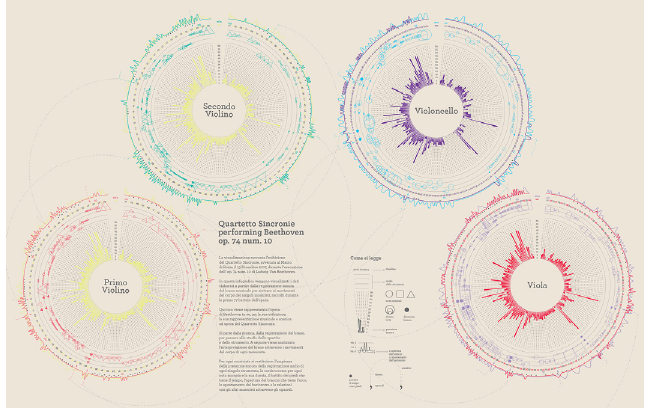
Fig. 28 Manlio Massimetti